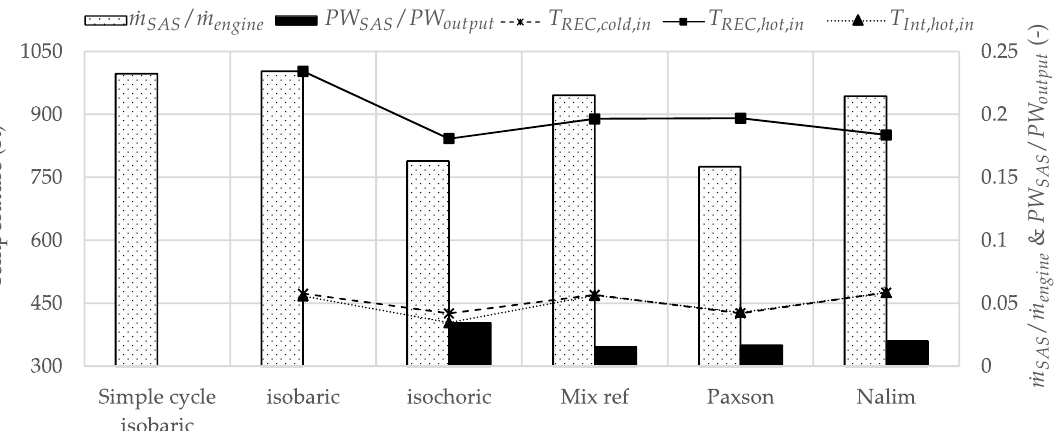
Figure 15. Intercooler and recuperator inlet temperatures and SAS mass flow and SAS compressor power for the intercooled-recuperated